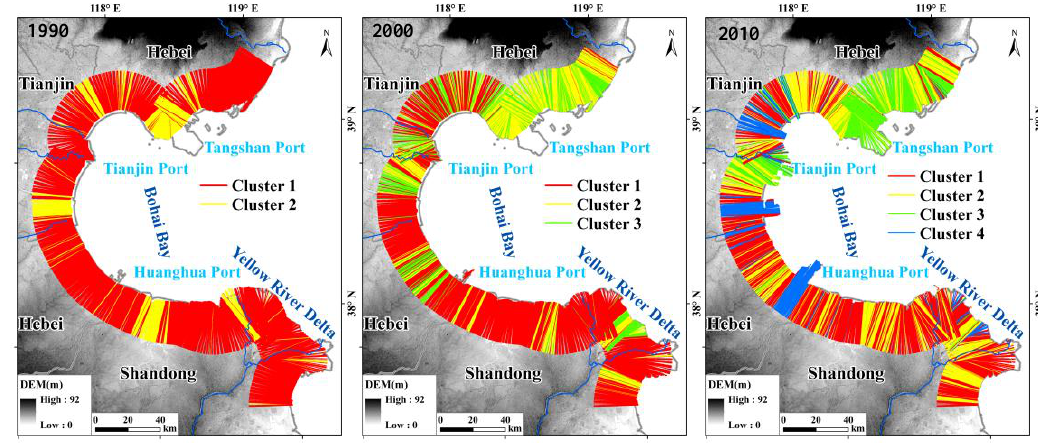
Figure 9. Spatial distribution of clusters of the CLUSPs from 1990 to 2010.